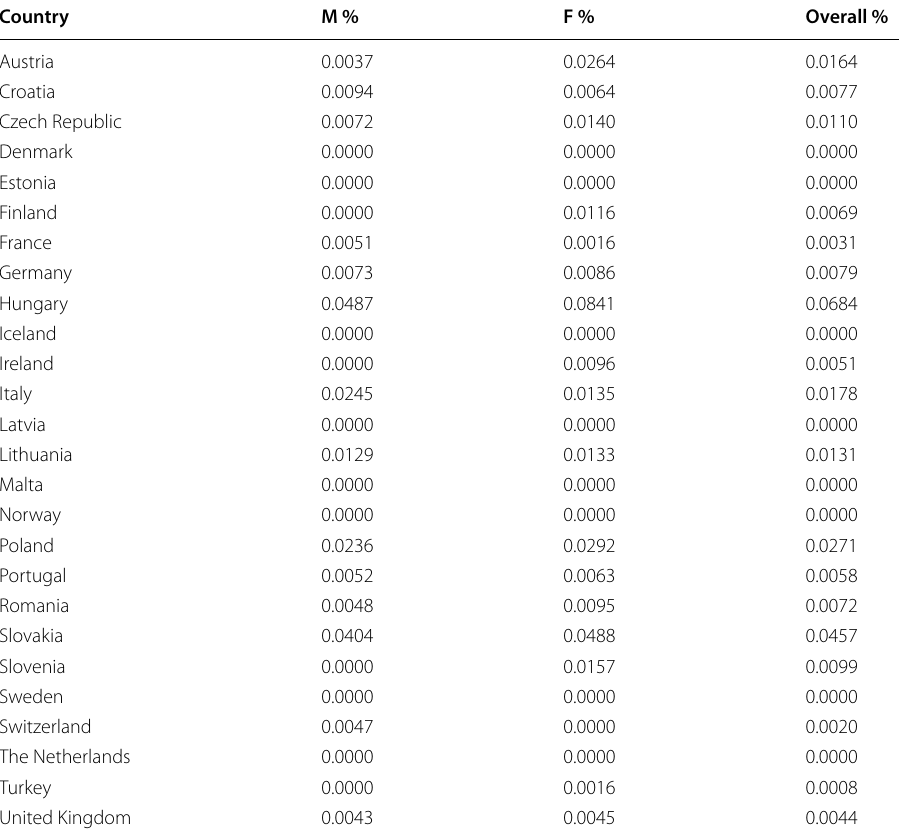
Table 1 Share of outgoing Erasmus students with disabilities over male, female and overall students with disabilities in HE in 2013, by country and by